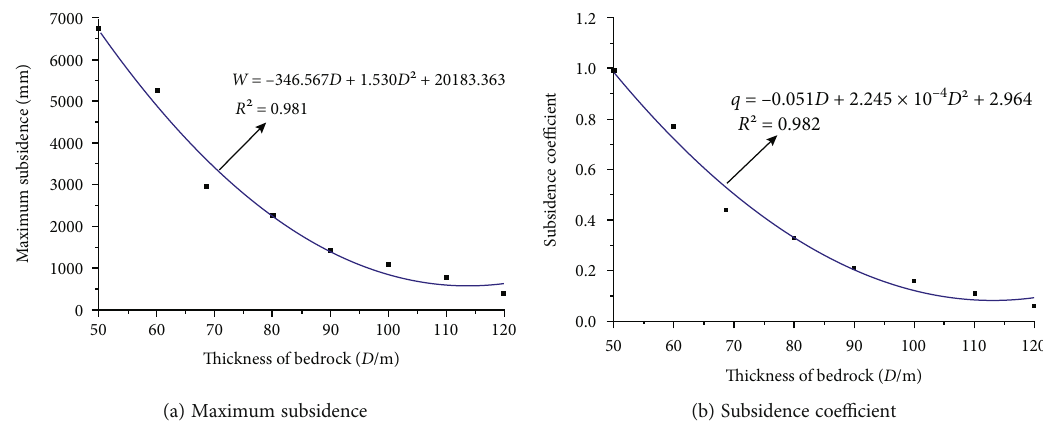
Figure 9: Fitting curve of maximum subsidence/subsidence coe ffi cient and thickness of bedrock.